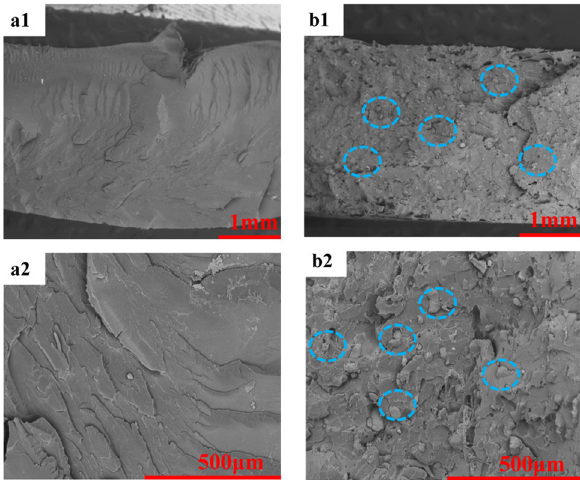
Figure A2: SEM image of LDPE/ ( EP@SB ) composite material.